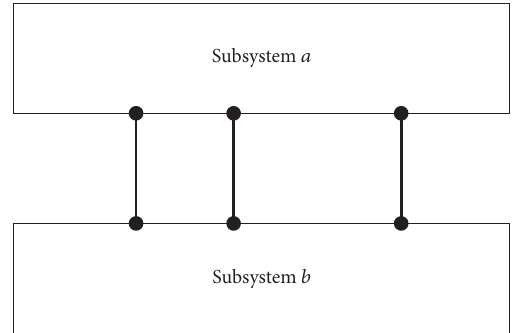
Figure 1: Two generic SEA subsystems connected via discrete